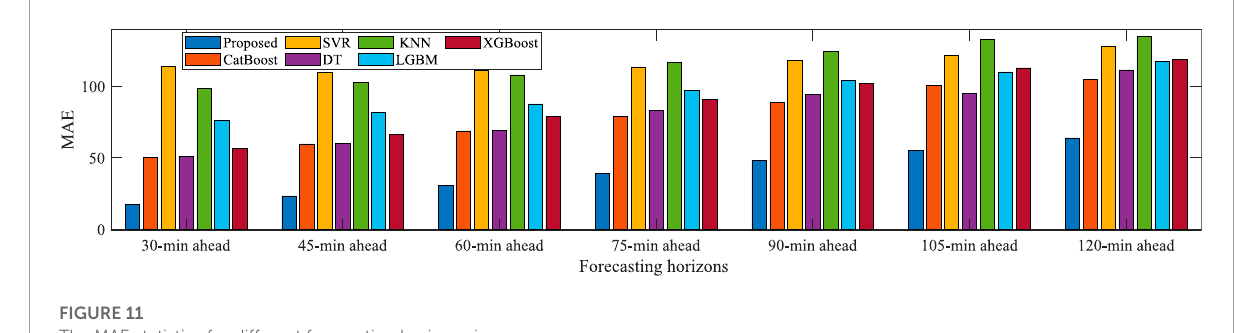
FIGURE 11 The MAE statistics for different forecasting horizons in